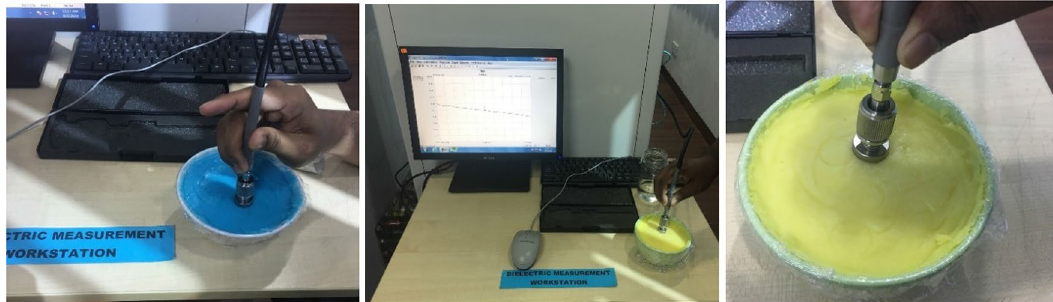
Figure 6. Measurement setup of the phantom components.